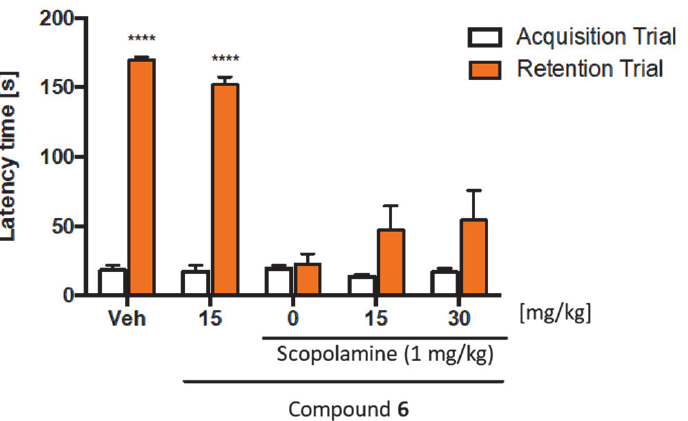
Figure 16. Activity of compound 6 in the Passive Avoidance Test. Compound 6 (15, or 30 mg/kg, i.p.) at the same volume of vehicle (1% Tween 80) was administered 30 min before the acquisition